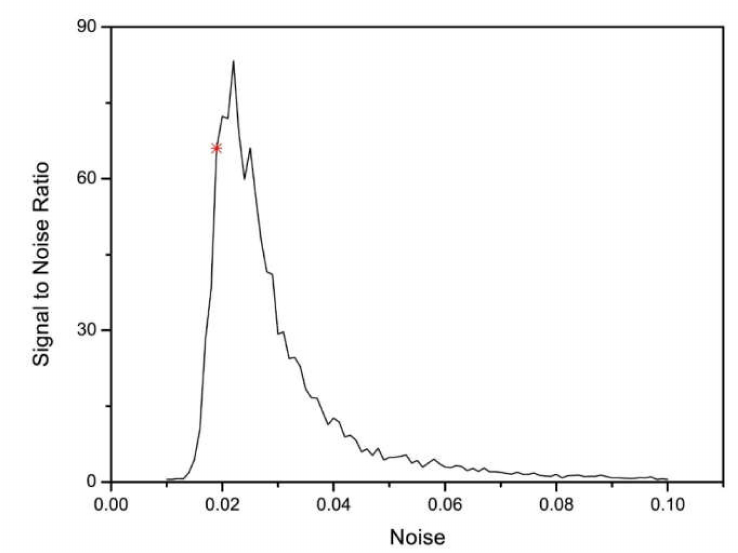
Figure 5. Signal to noise ratio curve: The maximum corresponds to a fully developed resonance. The red star corresponds to our level of resonance. From comparison with the experimental series, the level of noise is 0.02, whereas for a full resonance, the model requires a level of noise equal to about